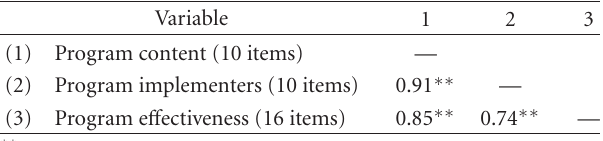
Table 7: Correlation coe ffi cients among the variables. Variable 1 2 3